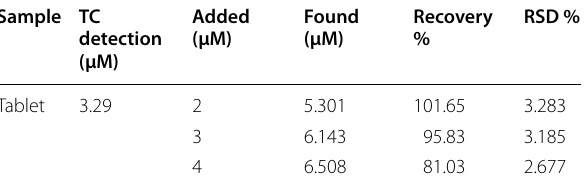
Table 1 Results for the determination of TC in drug tablet Sample TC detection